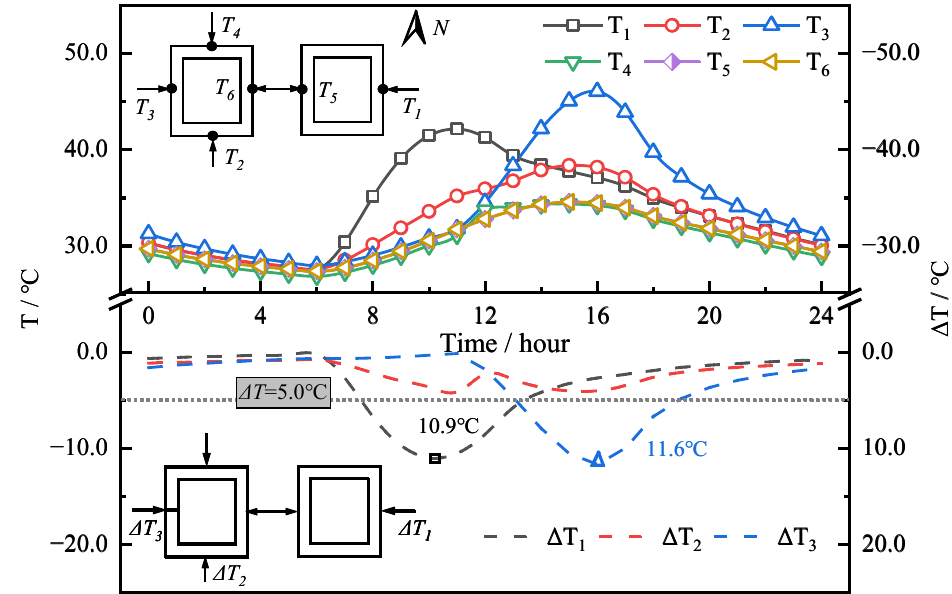
Figure 21. The temperature change curve of the outer surface of the tower wall at a height of 125 m and the temperature difference curve between the opposite faces of the tower column.